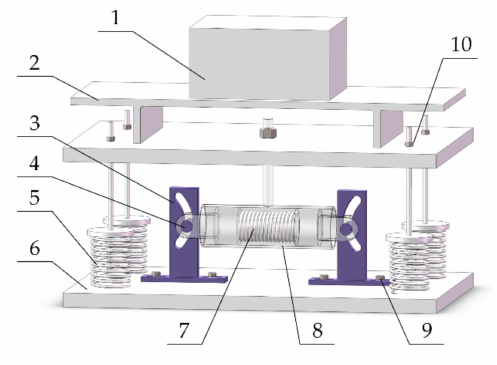
Figure 6. Physical model of nonlinear vibration isolator with